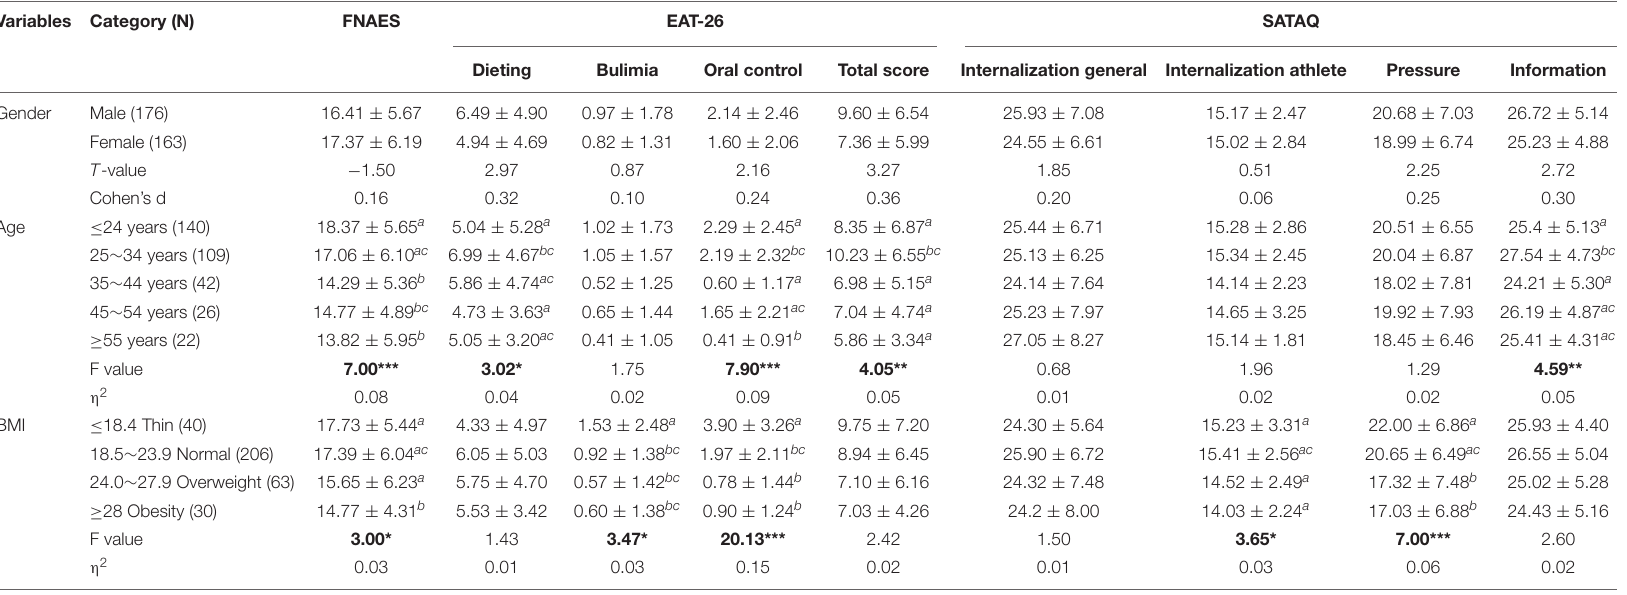
TABLE 1 | Participants’ scores on the FNAES, EAT-26, and SATAQ scales. Variables Category (N) FNAES EAT-26 SATAQ Dieting Bulimia Oral control Internalization general Internalization athlete